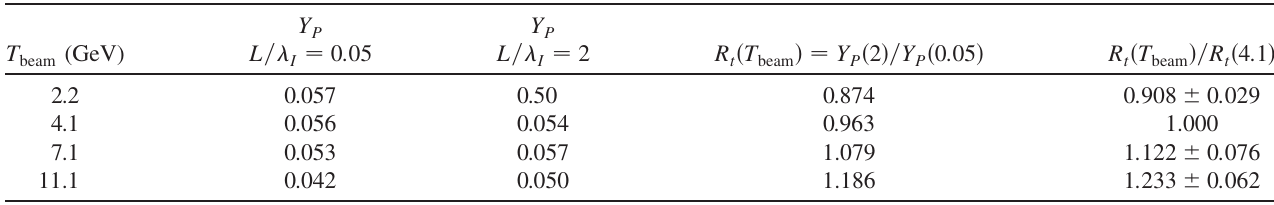
TABLE II. Beam power normalized yield of captured muons Y P calculated by MARS15 for thin and thick tantalum targets, and, in the last column, the ‘‘amplification factor’’ due to showering in the target, relative to the simple pion production cross section, normalized to the value at 4.1 GeV. Results are averages over calculation with the two different event generators.